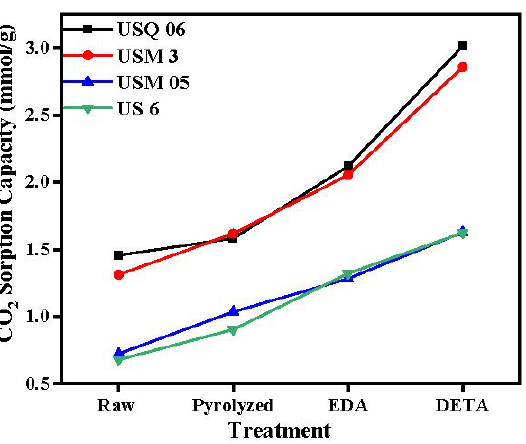
Figure 9. Changes in the CO 2 sorption capacity of each sample after various